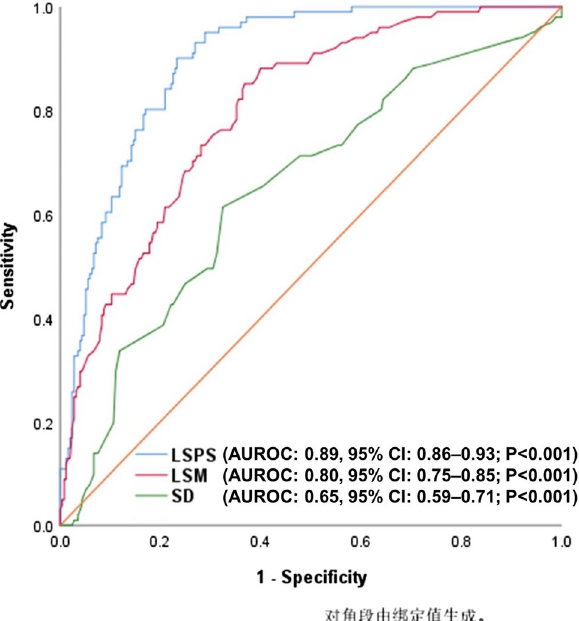
Figure 1. ROC curve of LSPS, LSM and SD; LSPS, liver stiffness-spleen size-to-platelet ratio risk score; LSM, liver stiffness measurement; SD, spleen diameter; AUROC, area under the receiver-operating characteristic curve.